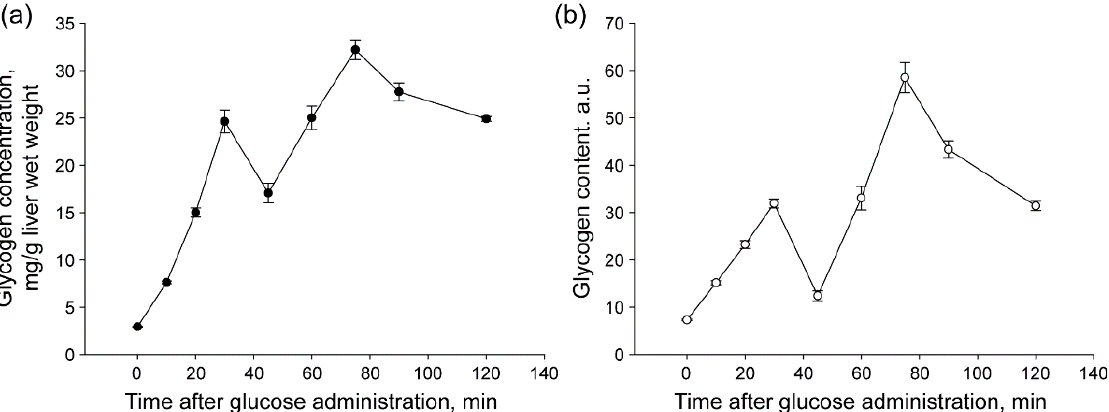
Figure 1. Dynamics of the liver glycogen concentration ( а ) and glycogen content in individual hepatocytes ( b ) at different stages of rat refeeding with glucose.